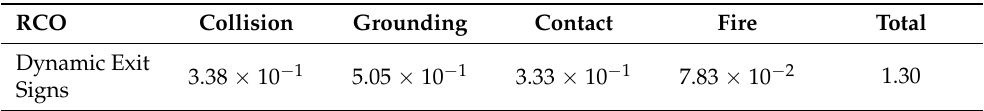
Table 6. Results for ∆ R (lives saved per ship/lifetime) for the RCO considered, per accident type and in